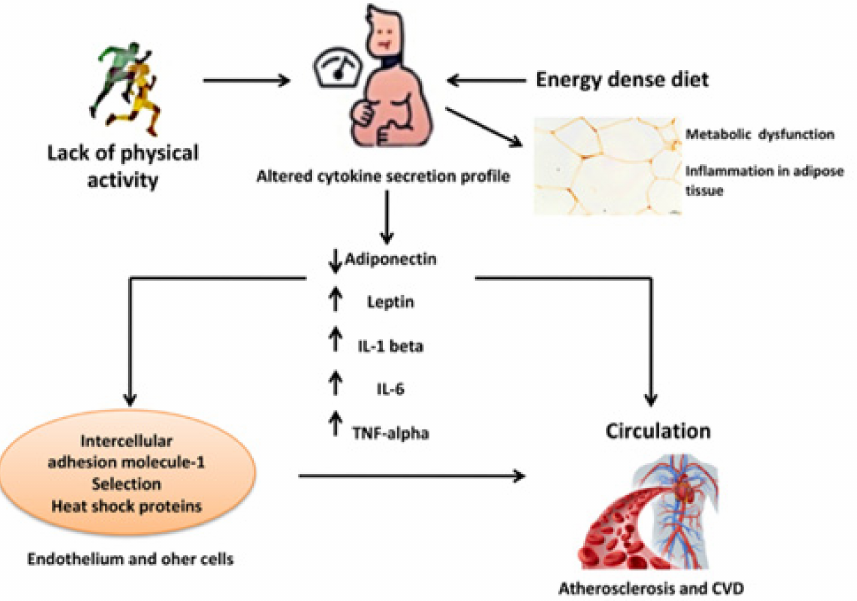
Figure 2. Cardiovascular disease (CVD) is related to inflammatory processes in obesity; modified from Mathieu et al., 2010